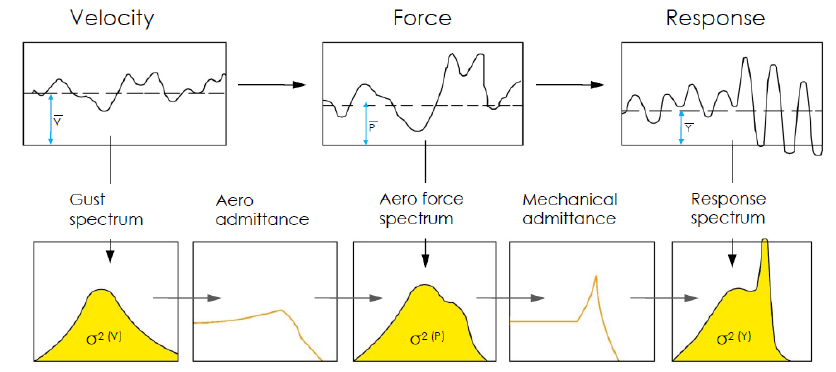
Figure 20. Elements of the statistical approach to gust loading [82].